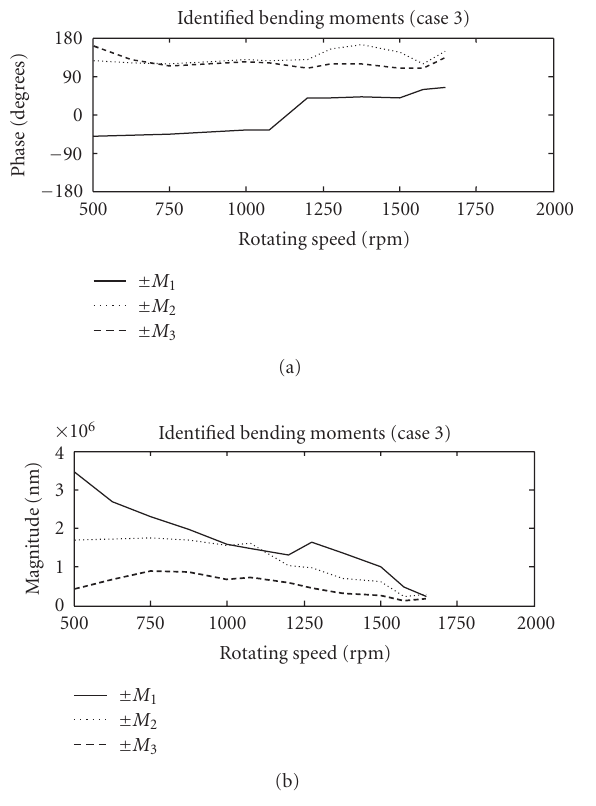
Figure 9: Magnitude and phase curves of the identified bending moments ± M 1 , ± M 2 , ± M 3 evaluated in the rotating speed range from 500rpm to 1600 rpm.